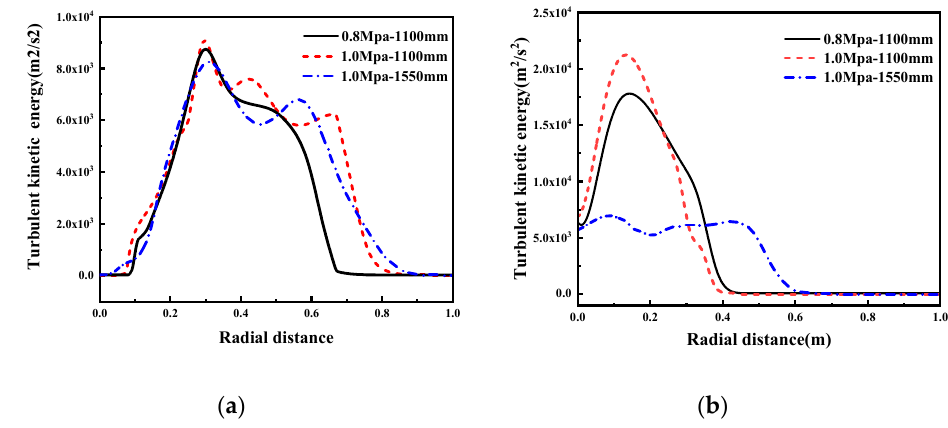
Figure 14. Radial distributions of turbulent kinetic energy of Laval and cyclone nozzles at the